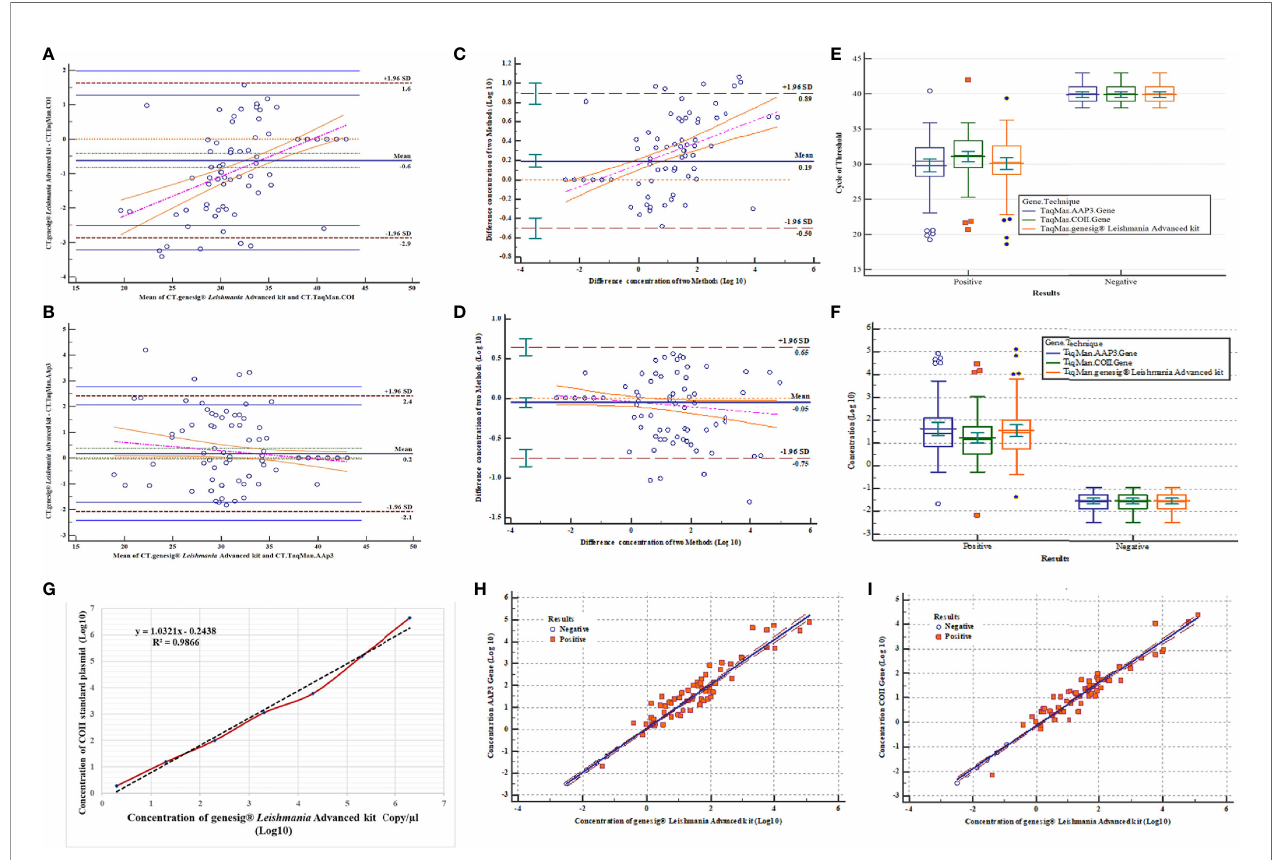
FIGURE 4 | Assessment of validation results and correlation of three qPCR assays. (A) Bland-Altman test for comparison of mean CT difference of 123 samples (77 positives and 46 negatives) for COII gene with genesig ® Leishmania Advanced Kit. (B) Bland-Altman test for comparing of mean CT difference of 123 samples for AAP3 gene with genesig ® Leishmania Advanced Kit. (C) Bland-Altman test for comparing of concentration differences (log10) of 123 samples for COII with genesig ® Leishmania Advanced Kit. (D) Bland-Altman test for comparing of concentration differences (log10) of 123 samples for AAP3 with genesig ® Leishmania Advanced Kit. (E) Comparison of mean CT difference plasmids of AAP3 and COII and genesig ® Leishmania Advanced kit based on negative and positive samples. (F) Comparison of concentration differences (log10) plasmids of AAP3, COII, and genesig ® Leishmania Advanced kit based on negative and positive samples. (G) Comparison of linear regression analysis of COII plasmid standards and genesig ® kit by linear equation (y = − 3.2193x + 35.017) obtained from genesig ® Leishmania Advanced kit. (H) Dispersion diagram with regression line to compare results of parasitic load concentration of genesig ® Leishmania Advanced Kit assay with AAP3 for 123 samples. (I) Dispersion diagram with regression line to compare results of parasitic load concentration of genesig ® Leishmania Advanced Kit assay with COII for 123